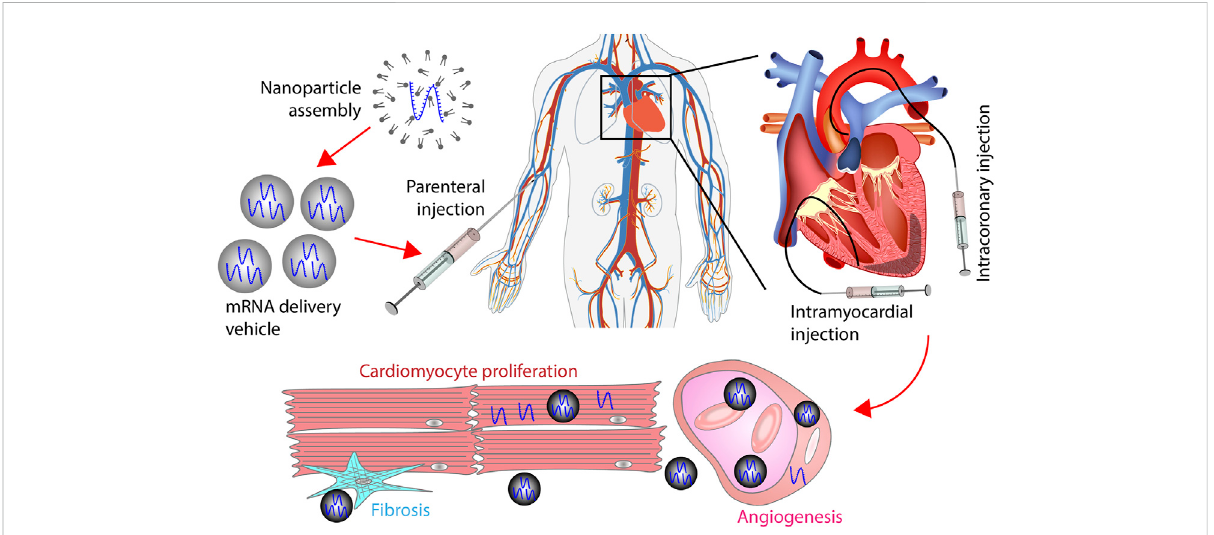
FIGURE 6 mRNAtherapyformyocardial infarction.mRNAsencapsulatedbyvehiclesareadministratedinto theheartthroughintravenous, subcutaneous, intracoronary, or intramyocardial injection. The route of administration can affect the percentage of mRNAs that reach the heart. In the heart, vehicles extravasate from the vessel to the extracellular space. Afterward, vehicles are internalized by cardiomyocytes, fi broblasts, endothelial cells, or smooth muscle cells. mRNAs delivered by vehicles promote cardiac regeneration by stimulating cardiomyocyte proliferation, increasing angiogenesis, and inhibiting fi